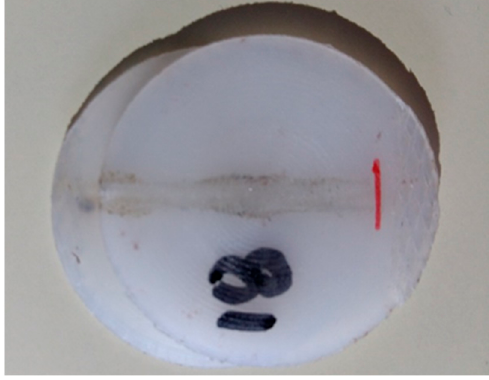
Figure 8. Sample after testing exhibiting interfacial failure (set 10).